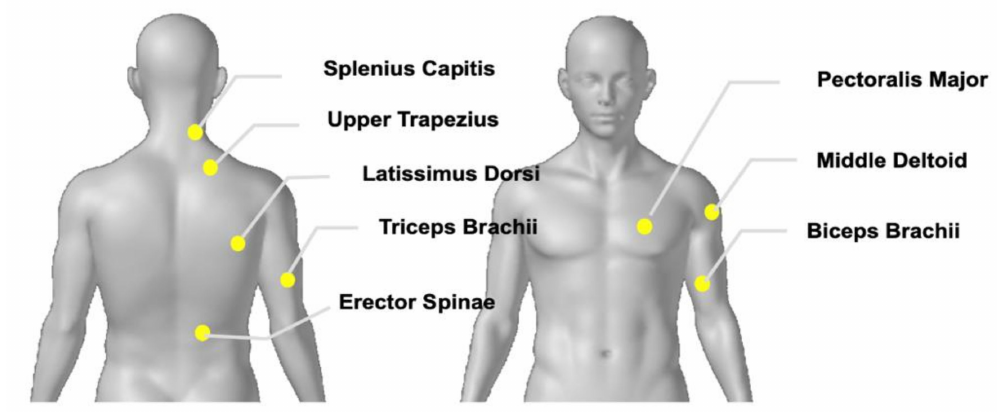
Figure 6. Eight target muscles to measure.